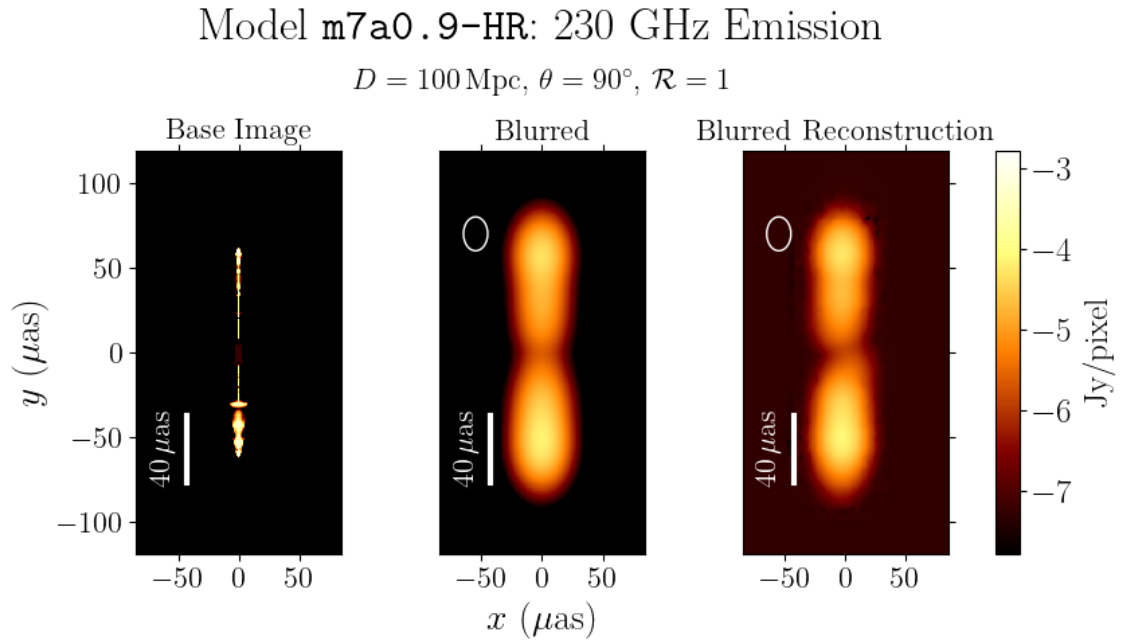
Figure 3. The same as Figure 2 but for model m7a0.9-HR at t = 78,000 t g imaged at D = 100 Mpc with θ = 90 ◦ and R =